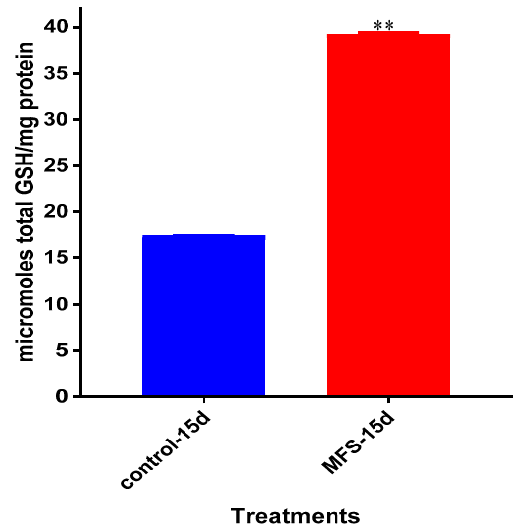
Figure 8. Levels of total GSH in untreated and MFS-treated granulomas from healthy subjects. Data represent means ± SE from eight healthy individuals. ** p < 0.005 when comparing GSH levels in control and MFS-treated groups.